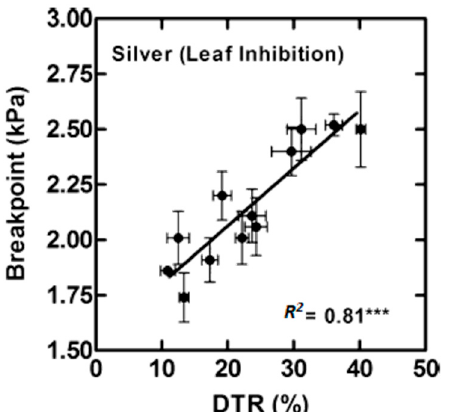
Figure 3. Twelve maize hybrids that were phenotyped for expressing a TR lim breakpoint in response to increasing VPD were also measured for decrease in transpiration rate (DTR) when exposed to silver ions (500 μ M) [43]. These results showed a high correlation the breakpoint and DTR reflecting apparent variation in aquaporins (AQP) sensitivity to silver. *** a significant correlation at P < 0.001.